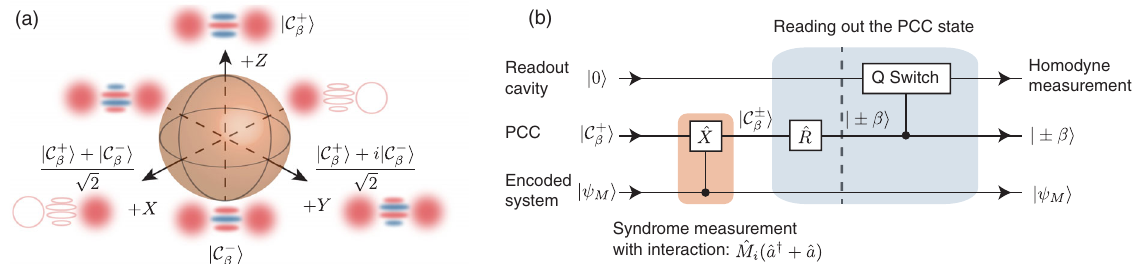
Syndrome measurement with interaction: FIG. 1. (a) Bloch sphere representation of cat states. (b) The figure shows the overview of syndrome detection with a PCO. The first step is to map the error syndrome on the state of the PCO j C þ β i or j C − β i via a controlled X rotation. The next step is to read out the state of the cat, which proceeds in two stages. The first stage is to rotate the cats j C (cid:3) β i to the coherent states ≈ j (cid:3) β i (using the procedure described in the main text). In the second stage, a single-photon exchange coupling between the PCO and a low- Q readout oscillator is turned on, a process known as the Q switch . This coupling leads to the displacement of the readout oscillator conditioned on the PCO state. Lastly, a homodyne measurement of the signal from the low- Q oscillator reveals the state of the PCO, thereby yielding the error